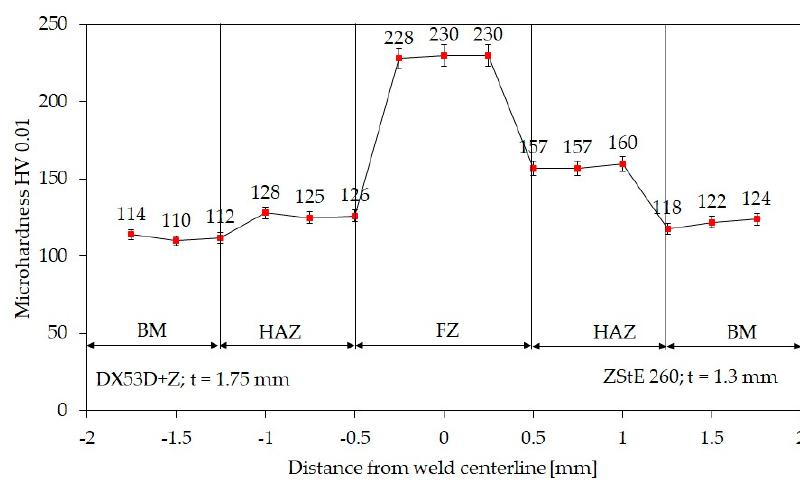
Figure 6. Microhardness distribution of TWB1.